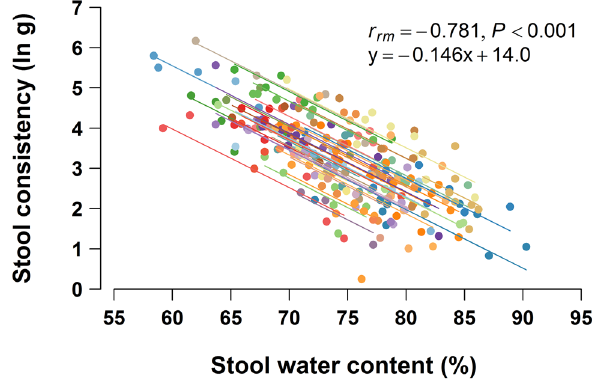
Figure 1. Correlation of stool consistency with stool water content. Repeated-measures correlation of stool consistency against stool water content was evaluated on 252 samples. Plots from the same subject were given the same color, and with corresponding line to show the best linear fit for each subject.